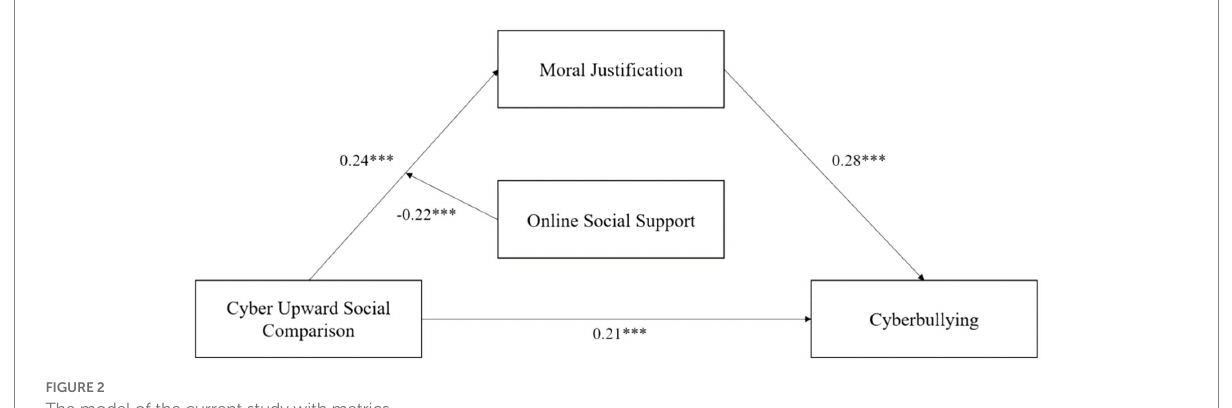
FIGURE 2 The model of the current study with